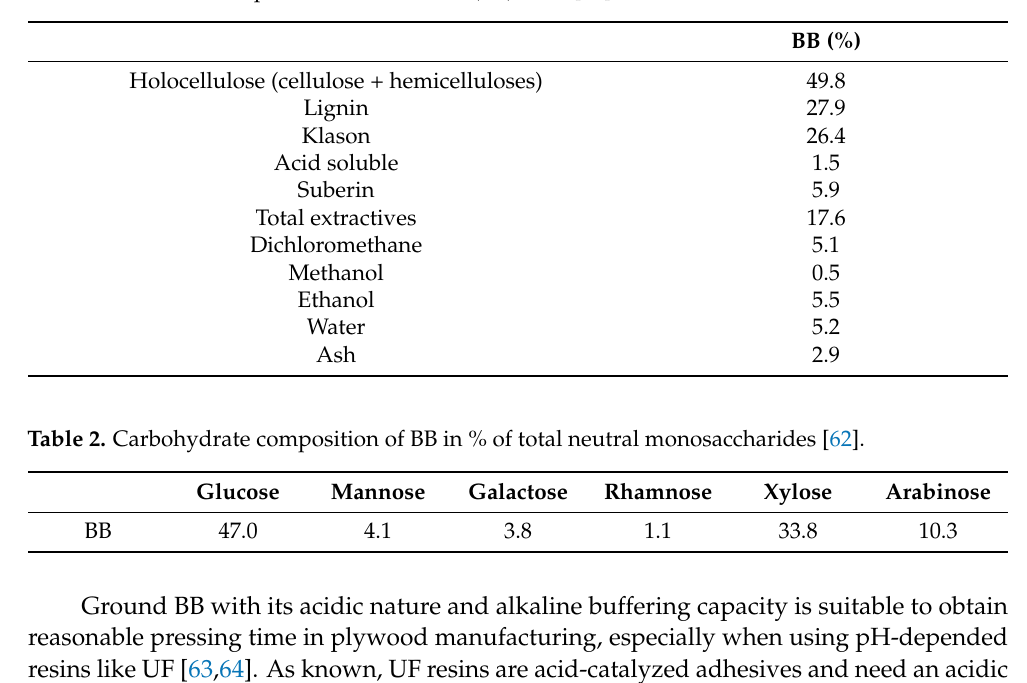
Table 1. Chemical composition of birch bark (BB) flour [62].